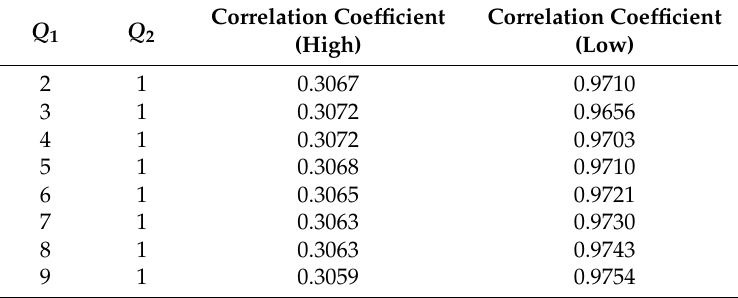
Table 2. Correlation coefficients when Q 1 varies from 2 to 9.